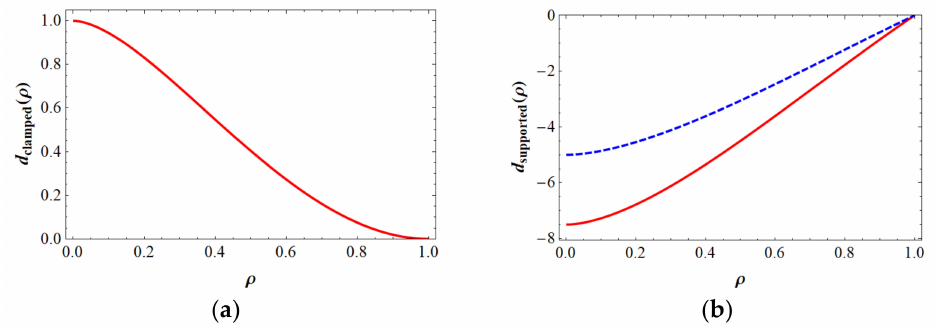
Figure 8. ( a ) The deformation d clamped versus the normalized radial coordinate ρ . ( b ) The deformation d supported versus the normalized radial coordinate ρ for a Poisson ratio σ = 0.3 (red line) and σ = 0.2 (blue dashed